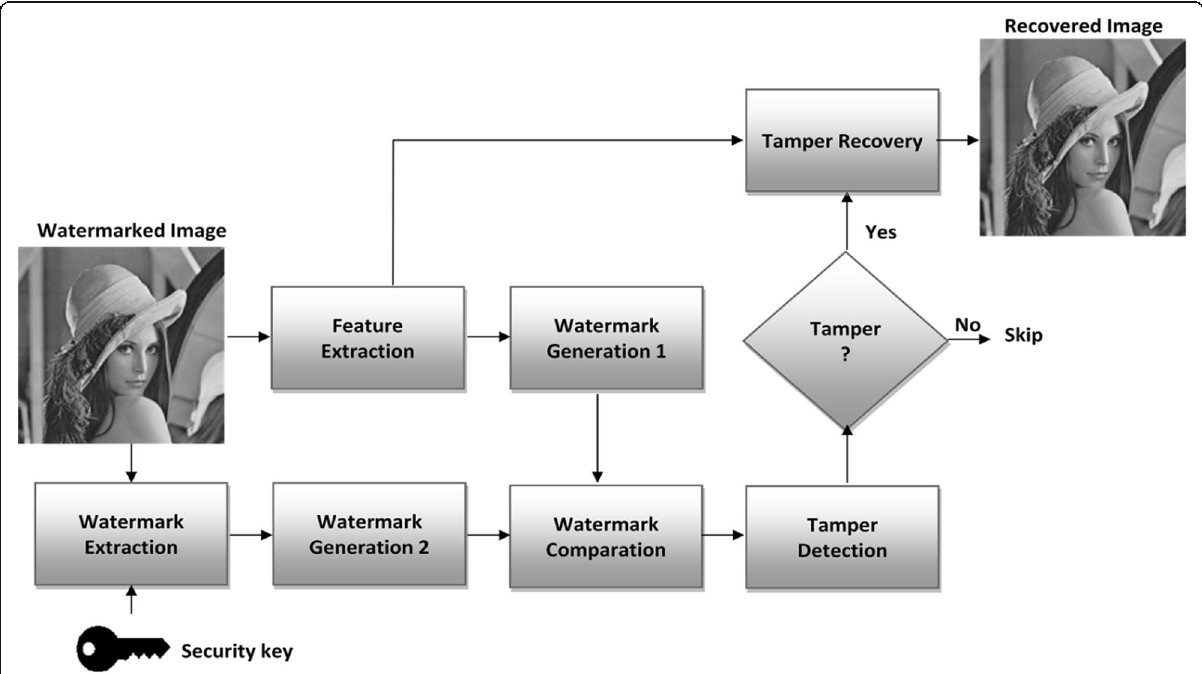
Fig. 3 Block diagram of watermark recovery process